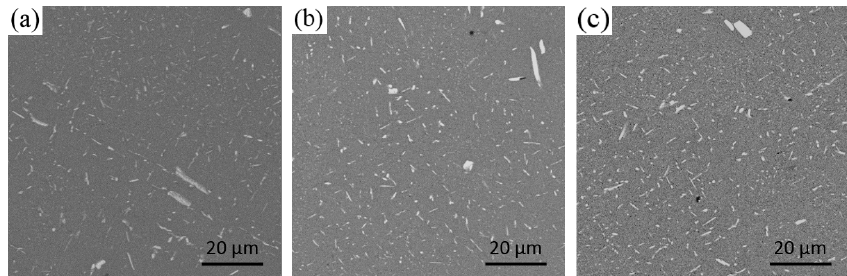
Figure 7. Distribution of the secondary phase of the ingots under different processing conditions: ( a ) Center of ingot without ultrasonic; ( b ) 1/2 radius of ingot without ultrasonic; ( c ) edge of ingot without ultrasonic; ( d ) center of ingot by L-shaped ultrasonic; ( e ) 1/2 radius of ingot by L-shaped ultrasonic; ( f ) edge of ingot by L-shaped ultrasonic; ( g ) center of ingot by straight-rod ultrasonic; ( h ) 1/2 radius of ingot by straight-rod ultrasonic; and ( i ) edge of ingot by straight-rod ultrasonic.